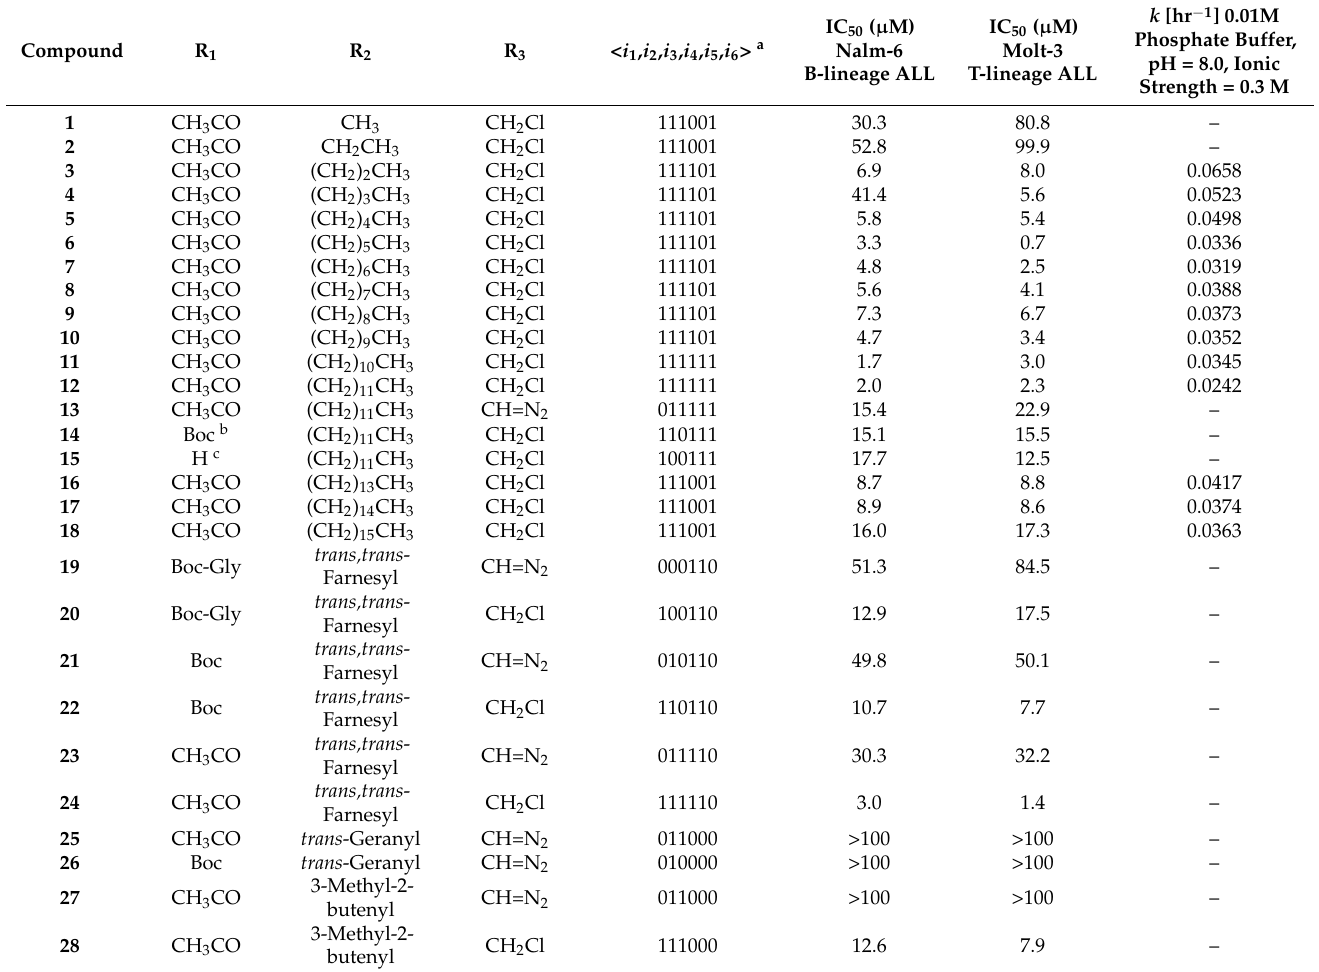
Table 1. Vector of properties of Cys diazo- and chloromethyl-ketone derivatives and experimental data of antileukemic activity (IC 50 ) and stability k